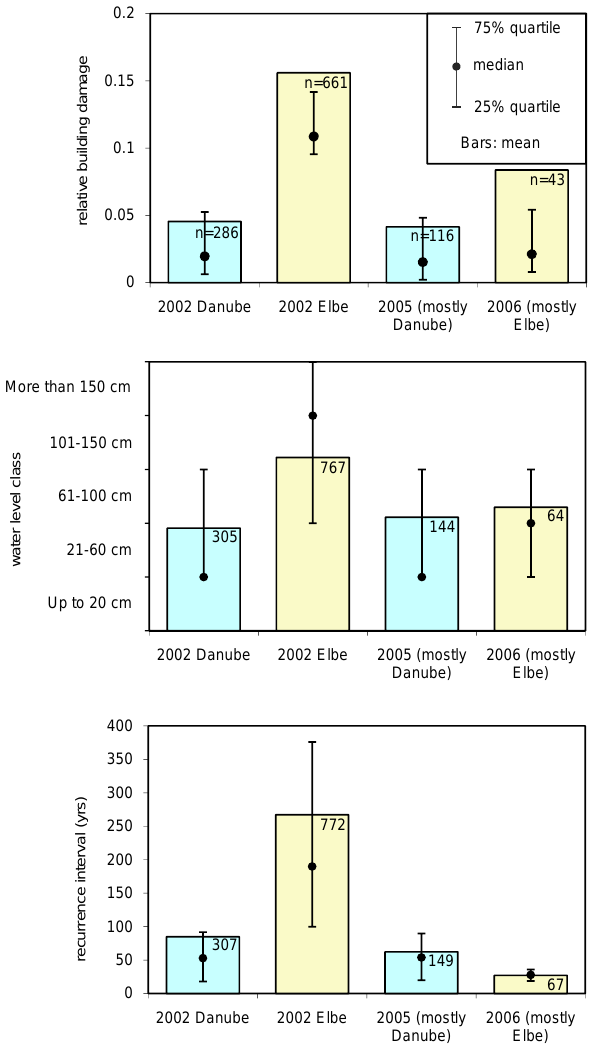
Fig. 1. Comparison of flood event averages: building loss ratios, water level classes, recurrence intervals (top to bottom) for cases with loss information.